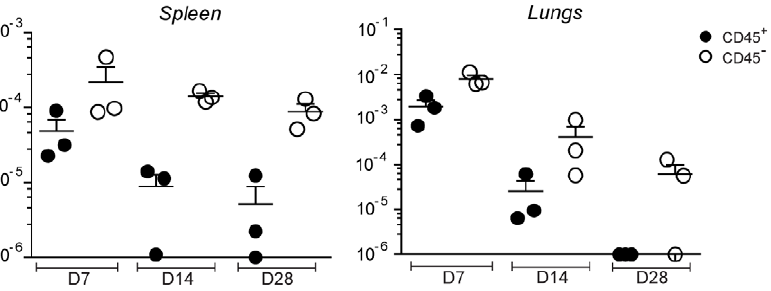
Figure 6. MCMV genome localizes preferentially in non-hematopoietic cells. C57BL/6 mice were infected with MCMV- D m157 and on day 7, 14 and 28 post infection total cells from the spleen and the lungs were sorted into CD45 + (black circles) and CD45 - (white circles) cell populations. MCMV latent genomes were quantified by qPCR using primers specific for b -actin and the MCMV-encoded M38 gene. One of two independent experiments is shown.